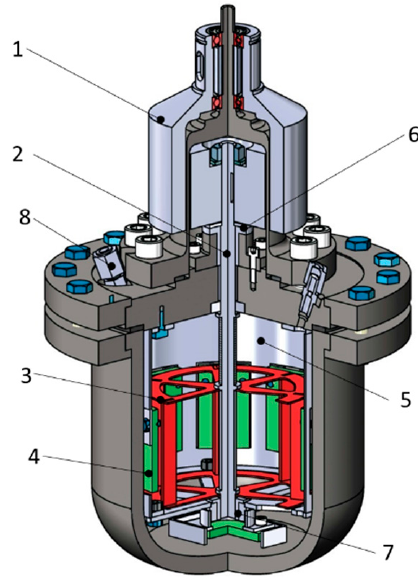
Figure 3. Design of the modified RCA method autoclave. 1—Magnetic Coupling; 2—Shaft; 3—Cage; 4—Samples; 5—Drum; 6, 7—Plain Bearings; 8—Fittings